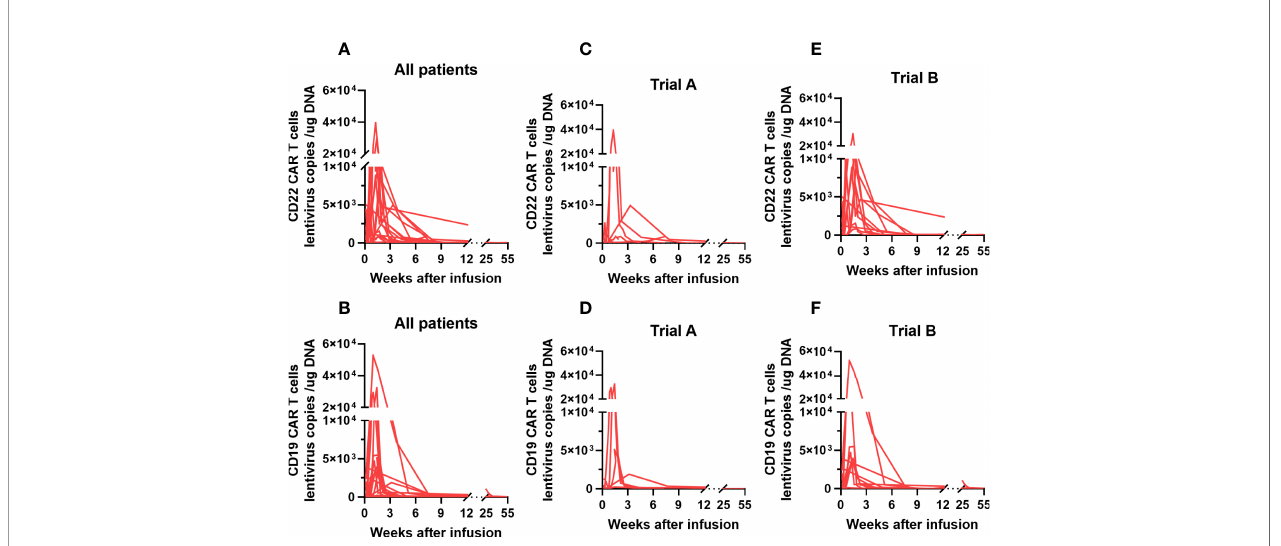
FIGURE 4 | CAR T cell kinetics in adult patients with r/r Burkitt lymphoma enrolled in our study. (A, B) The median peak levels of CD22 and CD19 CAR T cell lentivirus copies in our study patients were 6951 (range: 141 – 39503) and 3930.5 (range: 125 – 69036) copies/µg DNA, respectively. (C-F) The median peak levels of CD22 and CD19 CAR T cell lentivirus copies were 2627 (range: 141 – 39503) and 1898 (range: 130 – 32422) copies/µg DNA, respectively, in trial A; and 9724 (range: 1000 – 30034) and 3939 (range: 125 – 69036) copies/µg DNA, respectively, in trial (B) CAR, chimeric antigen receptor; r/r, refractory/relapsed.